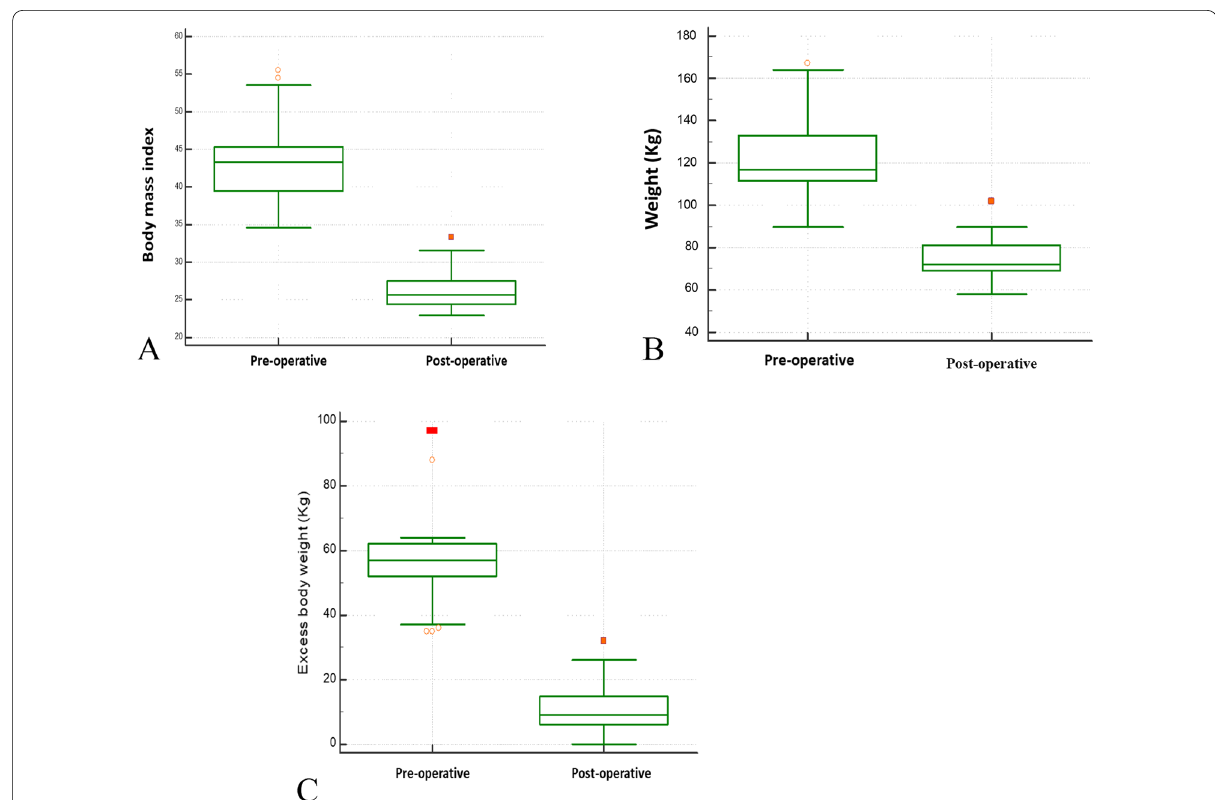
Fig. 1 Box‑and‑whisker plot of the preoperative and 12‑month postoperative BMI (A), weight (B) and excess weight (C) of all patients. Whiskers represent range, bars represent the 25th and 75th percentiles and lines represent median values. Outliers are marked by colored